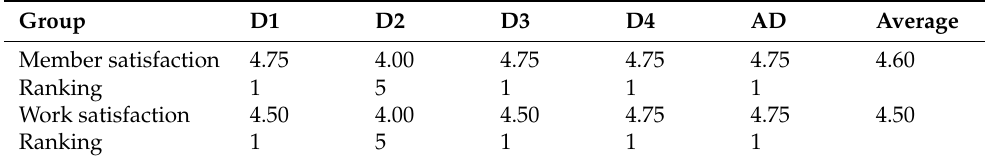
Table 4. Depression Groups’ Self-Rated